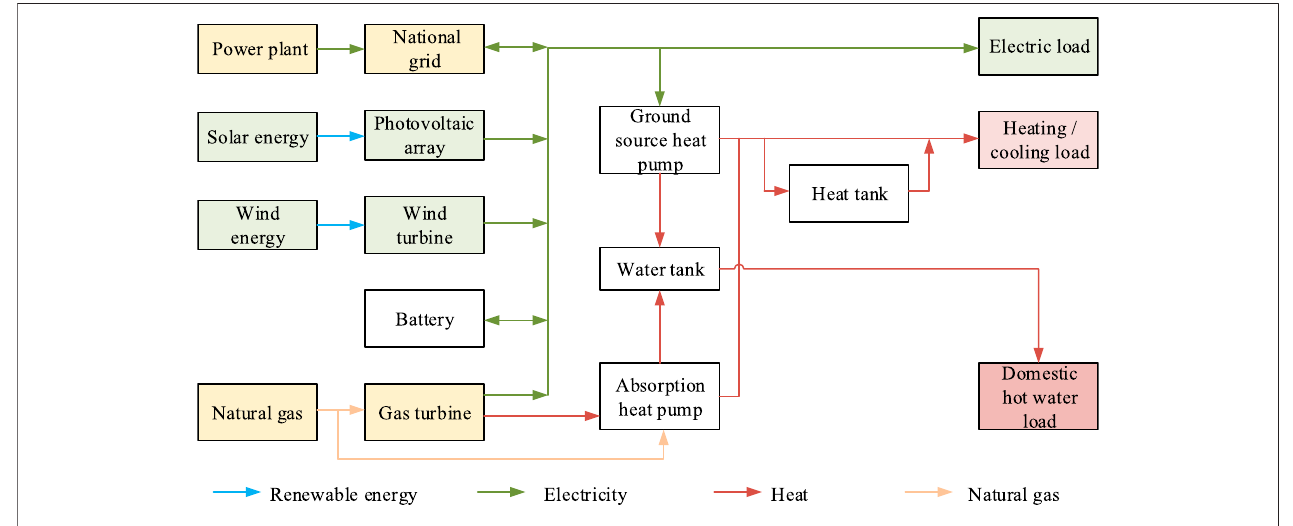
FIGURE 1 | Energy fl ows of a micro-grid integrated with natural gas and renewable energies.